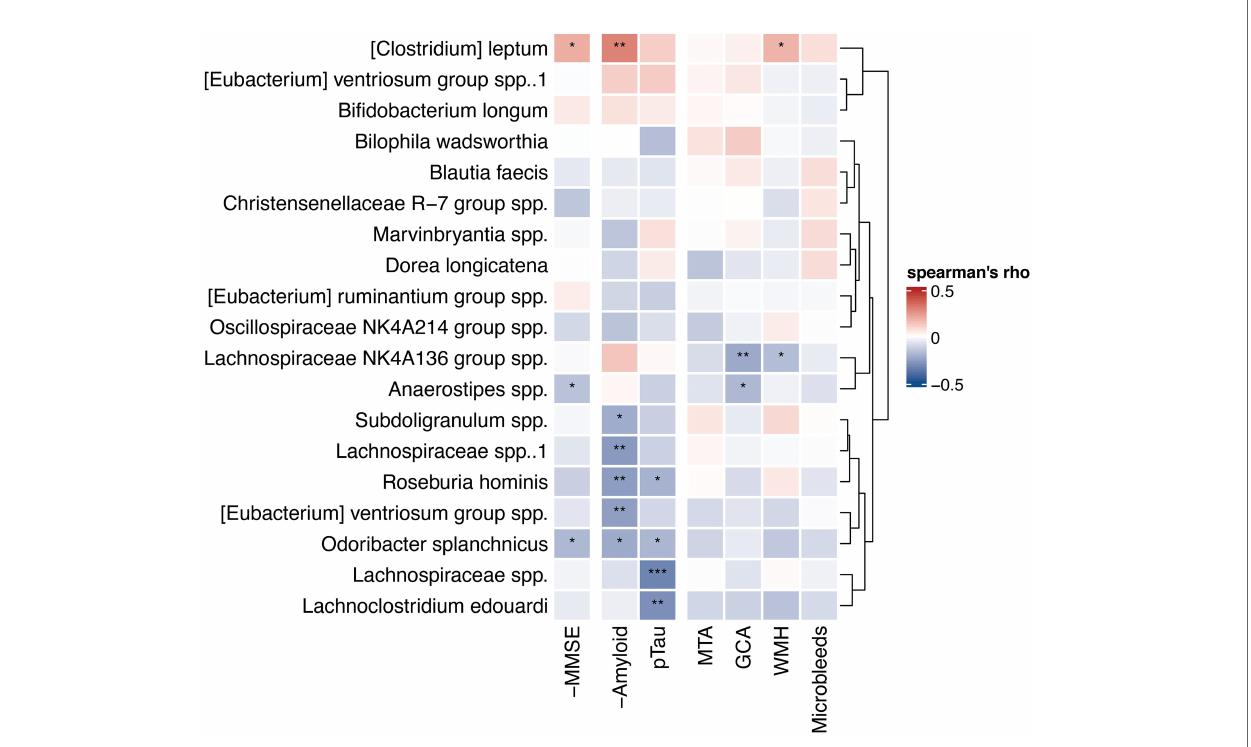
FIGURE 5 | Heatmap of correlations with highest ranked predictors. Spearman ’ s correlations between 10 highest ranked microbial predictors from the amyloid and p-tau machine learning models and continuous AD biomarkers. Hierarchical clustering (Ward ’ s method) was used to order the microbes and draw the dendrogram on the right. Correlations with MMSE and amyloid CSF levels are reversed for interpretability (-MMSE and -Amyloid), as lower values of these variables are indicative for pathology, in contrast to the other biomarkers. Negative (blue) correlations in this heatmap re fl ect correlations with less biomarkers indicative for AD pathology. *p < 0.05, **p < 0.01, ***p < 0.001. MMSE, mini-mental state examination; P-tau, phosphorylated tau; MTA, medial temporal atrophy; GCA, global cortical atrophy; WMH, white matter